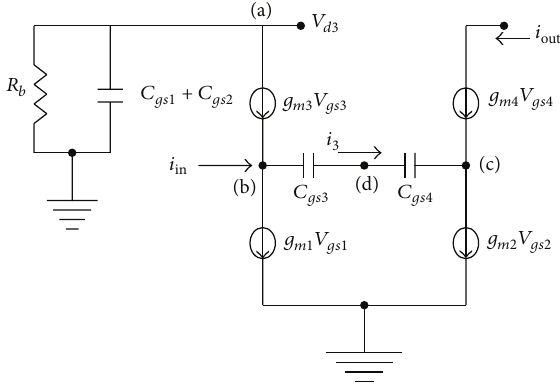
Figure 3: Small signal model of LVCCM (shown in Figure